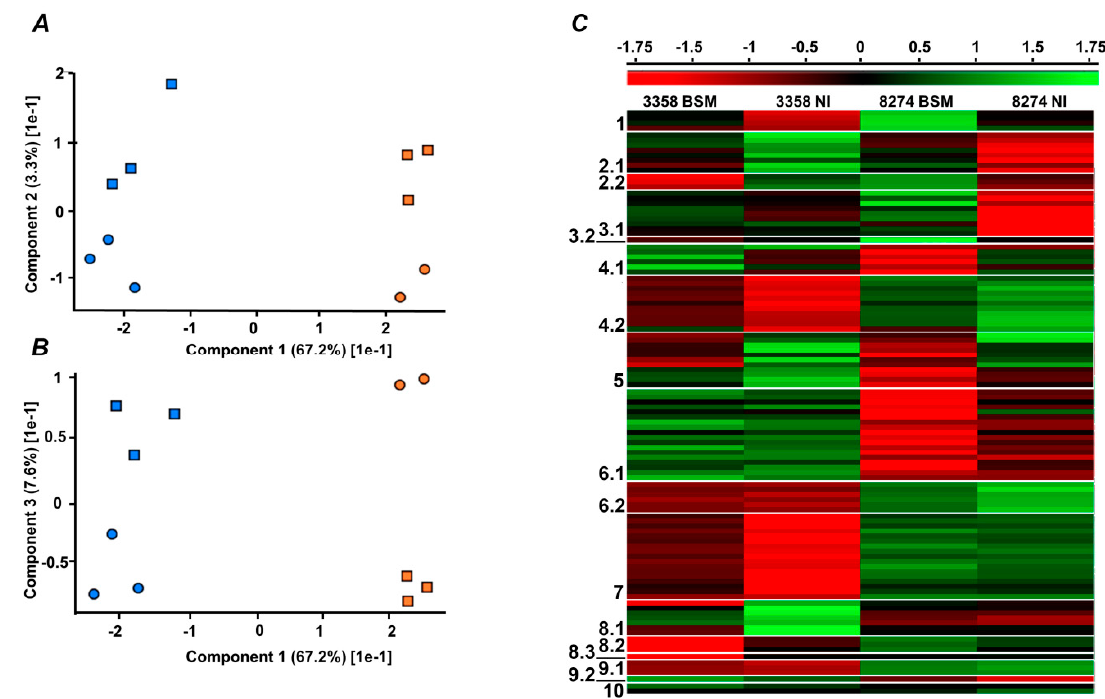
Figure 3. Post-processing of the label-free quantification data, acquired in nanoHPLC-ESI-Q- Figure 3 Post-processing of the label-free quantification data, acquired in Orbitrap-MS / data-dependent acquisition experiments, performed with seed protein tryptic digests nanoHPLC-ESI-Q-Orbitrap-MS/data-dependent acquisition experiments, performed with seed of pea ( P. sativum L) plants, lines K-8274 (high EIBSM, A ) and K-3358 (low EIBSM, B ), grown with protein tryptic digests of pea ( P. sativum L) plants, lines K-8274 (high EIBSM, A ) and K-3358 (low (BSM, beneficial soil microorganisms) and without (NI, not inoculated) simultaneous colonization of EIBSM, B ), grown with (BSM, beneficial soil microorganisms) and without (NI, not inoculated) pea roots with rhizobia and arbuscular mycorrhizae (AM). The K-8274 (orange) and K-3358 (blue) pea simultaneous colonization of pea roots with rhizobia and arbuscular mycorrhizae (AM). The K-8274 lines could be separated by the first component ( A , B ), whereas BSM (squares) and NI (circles) were (orange) and K-3358 (blue) pea lines could be separated by the first component ( A,B ), whereas BSM separated by the second ( A ) and third ( B ) components. Hierarchical clustering was done for average (squares) and NI (circles) were separated by the second ( A ) and third ( B ) components. Hierarchical group values, calculated by three biological replicates ( C ). Post-processing relied on Perseus software clustering was done for average group values, calculated by three biological replicates ( C ). ( n = 3). For the original Perseus export data (i.e., prior manual verification of clusters) see Figure